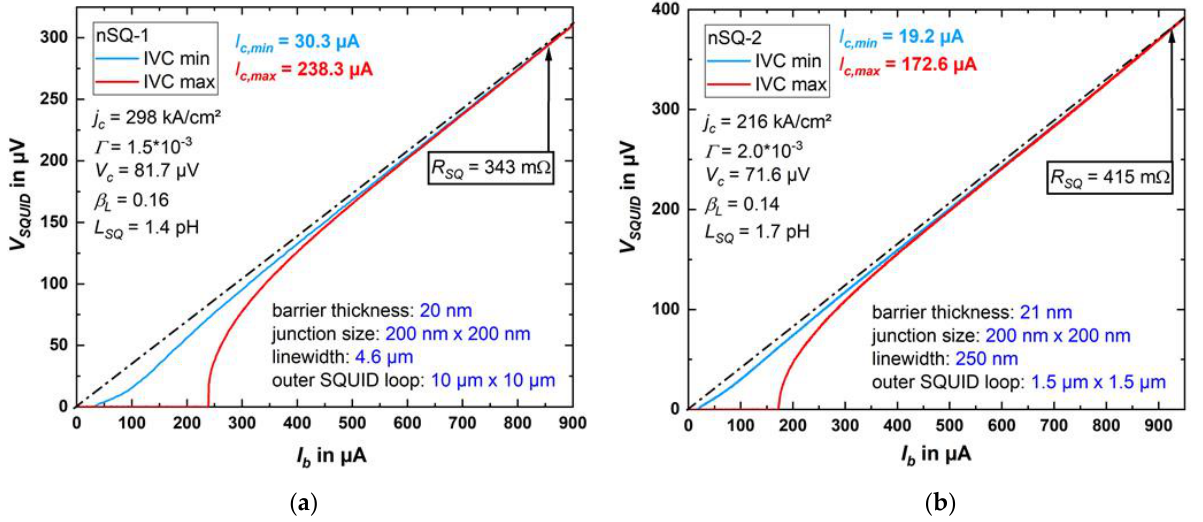
Figure 12. The current – voltage characteristics (IVCs) at 4.2 K of SQ-1 ( a ) and SQ-2 ( b ), with I mod adjusted to achieve maximum (IVC max) and minimum (IVC min) critical current. The characteristic electric transport and geometric parameters of the SQUIDs are indicated.